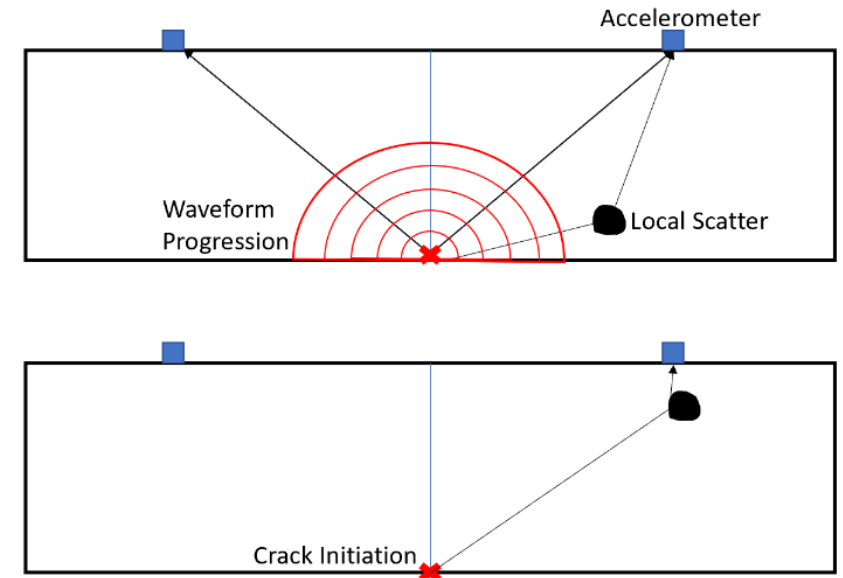
Figure 14. Local scatter